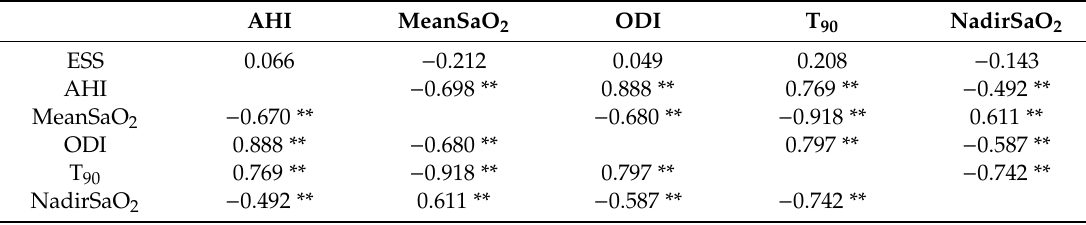
Table 3. Pearson correlations between polygraphic recording indices and Epworth Sleepiness Scale (ESS) in entire sample of OSA